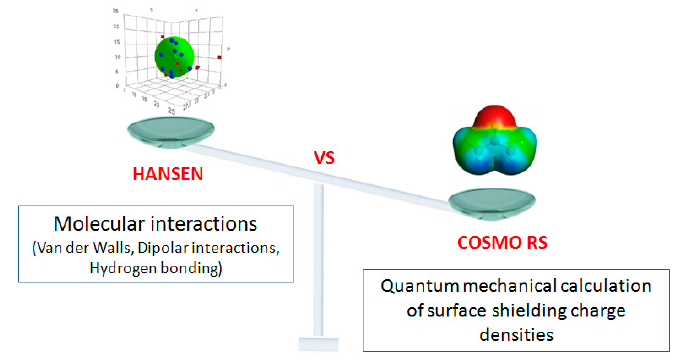
Figure 7. Comparison of computational methods: Hansen vs . COSMO-RS.